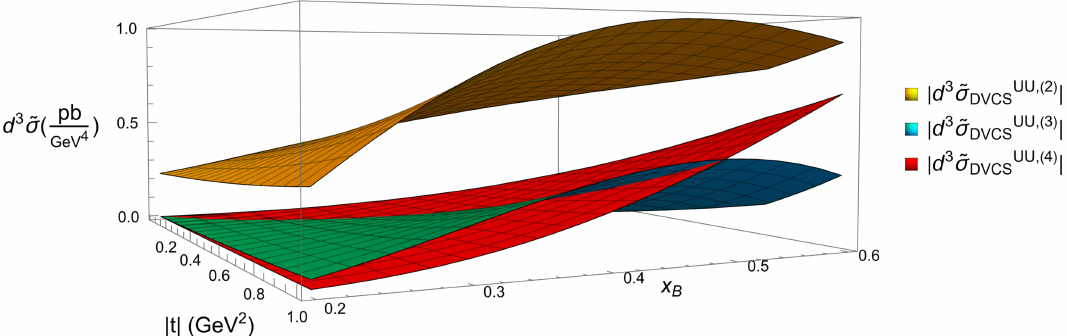
Figure 11 . A comparison of twist-two and twist-three pure DVCS cross-section coefficients at JLab 12 GeV kinematics with E = 10 . 59 GeV and Q 2 = 4 GeV 2 . The absolute values are taken b for comparison of the size. The leading-twist (the top yellow surface) effect is clearly dominating the other higher-twist effects in the small x regions, while the higher-twist effects (the lower two B surfaces) get more relevant as x increases. B